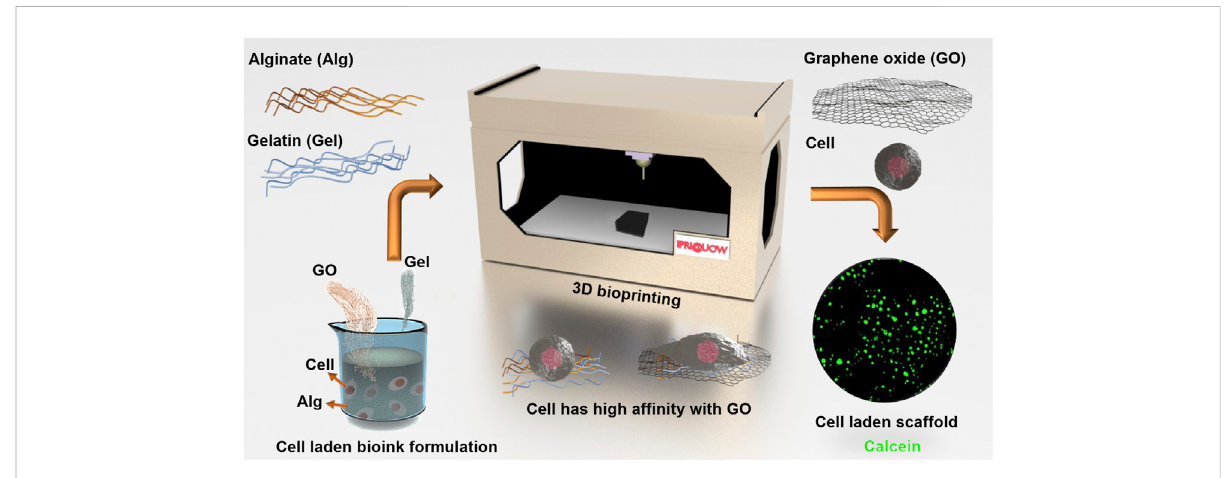
FIGURE 1 Schematic of ADSC-laden Alg/Gel/GO bio-ink preparation and 3D